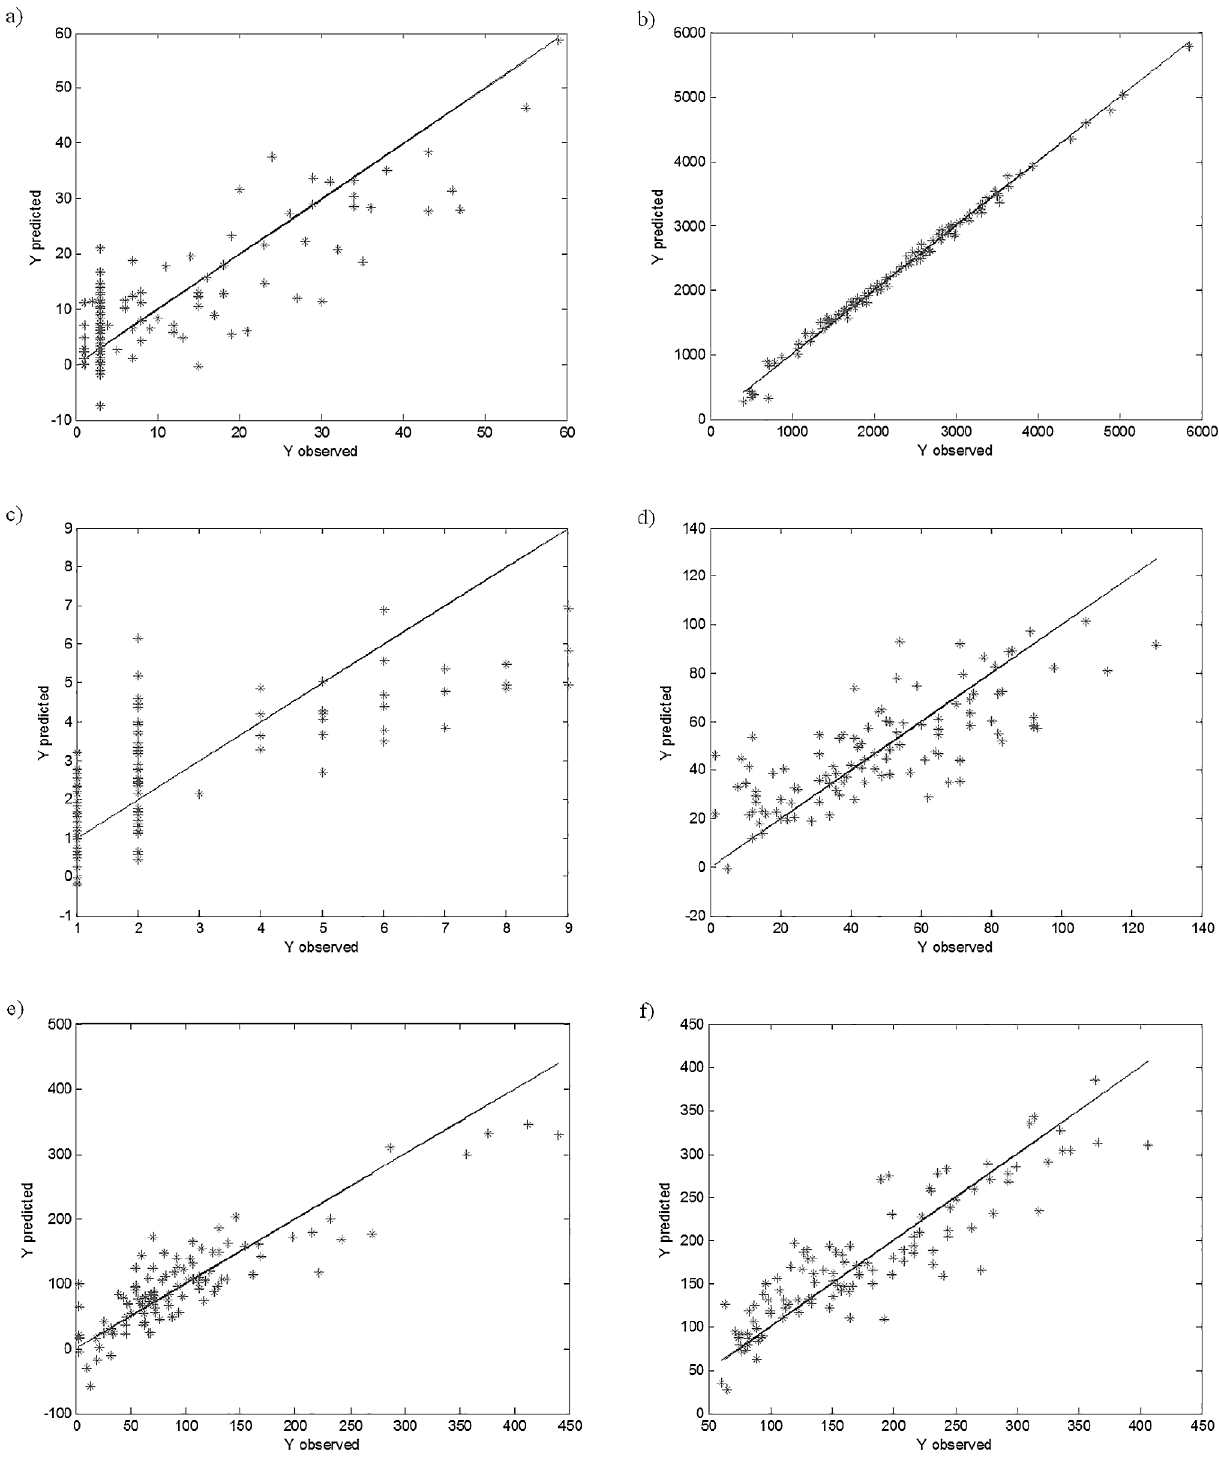
Fig 5. PLS model of trace elements concentrations: (a) As, (b) Ba, (c) Cd, (d) Co, (e) Cr, (f) Cu, (g) Mn, (h) Ni, (i) Pb, (j) Rb, (k) Sr, (l) V and (m) Zn in μ g/g, based on the parameters specified in Table 1, after correct identification and elimination of outlying elements.